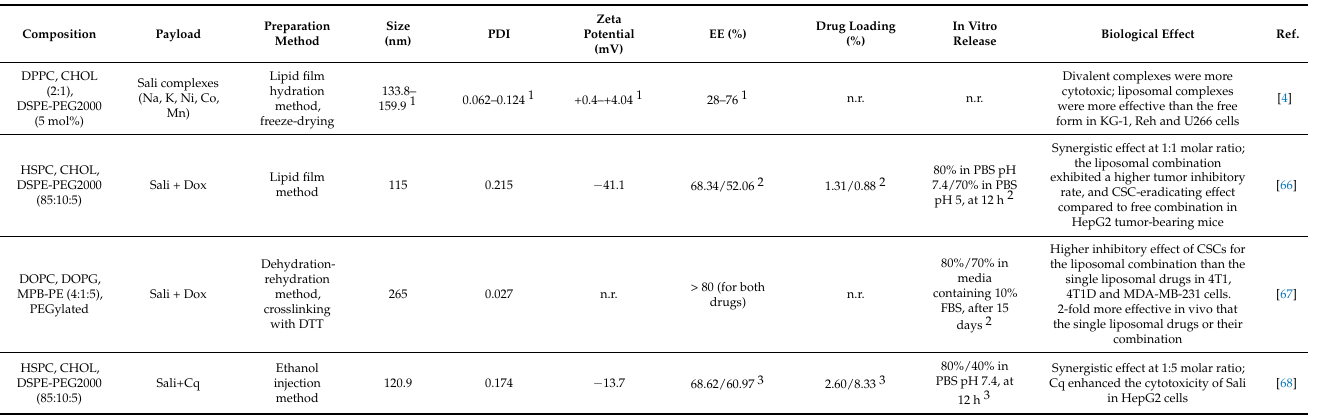
Table 2. Liposomal formulations with